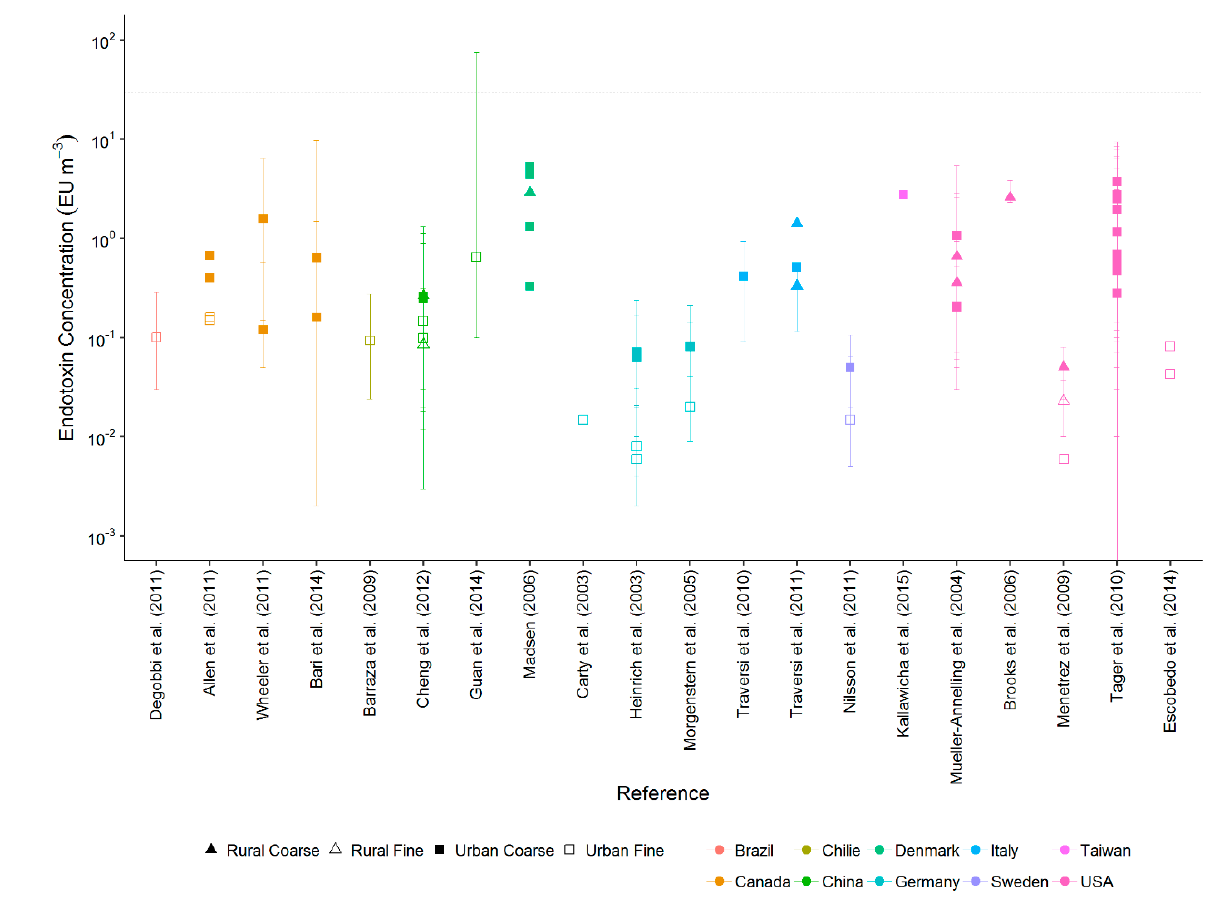
Figure 1. Endotoxin concentrations as reported in the literature at different size fractions in urban or rural environments (means or medians). Error bars indicate the range of concentrations reported. The dotted line indicates the proposed exposure limit of 30 EU m − 3 . Coarse indicates inhalable particulate matter (PM 10–2.5 ) with the exception of Allen et al. (2011) [21] and Menetrez et al. (2009) [14], who reported PM 10 ; fine indicates PM 2.5 .